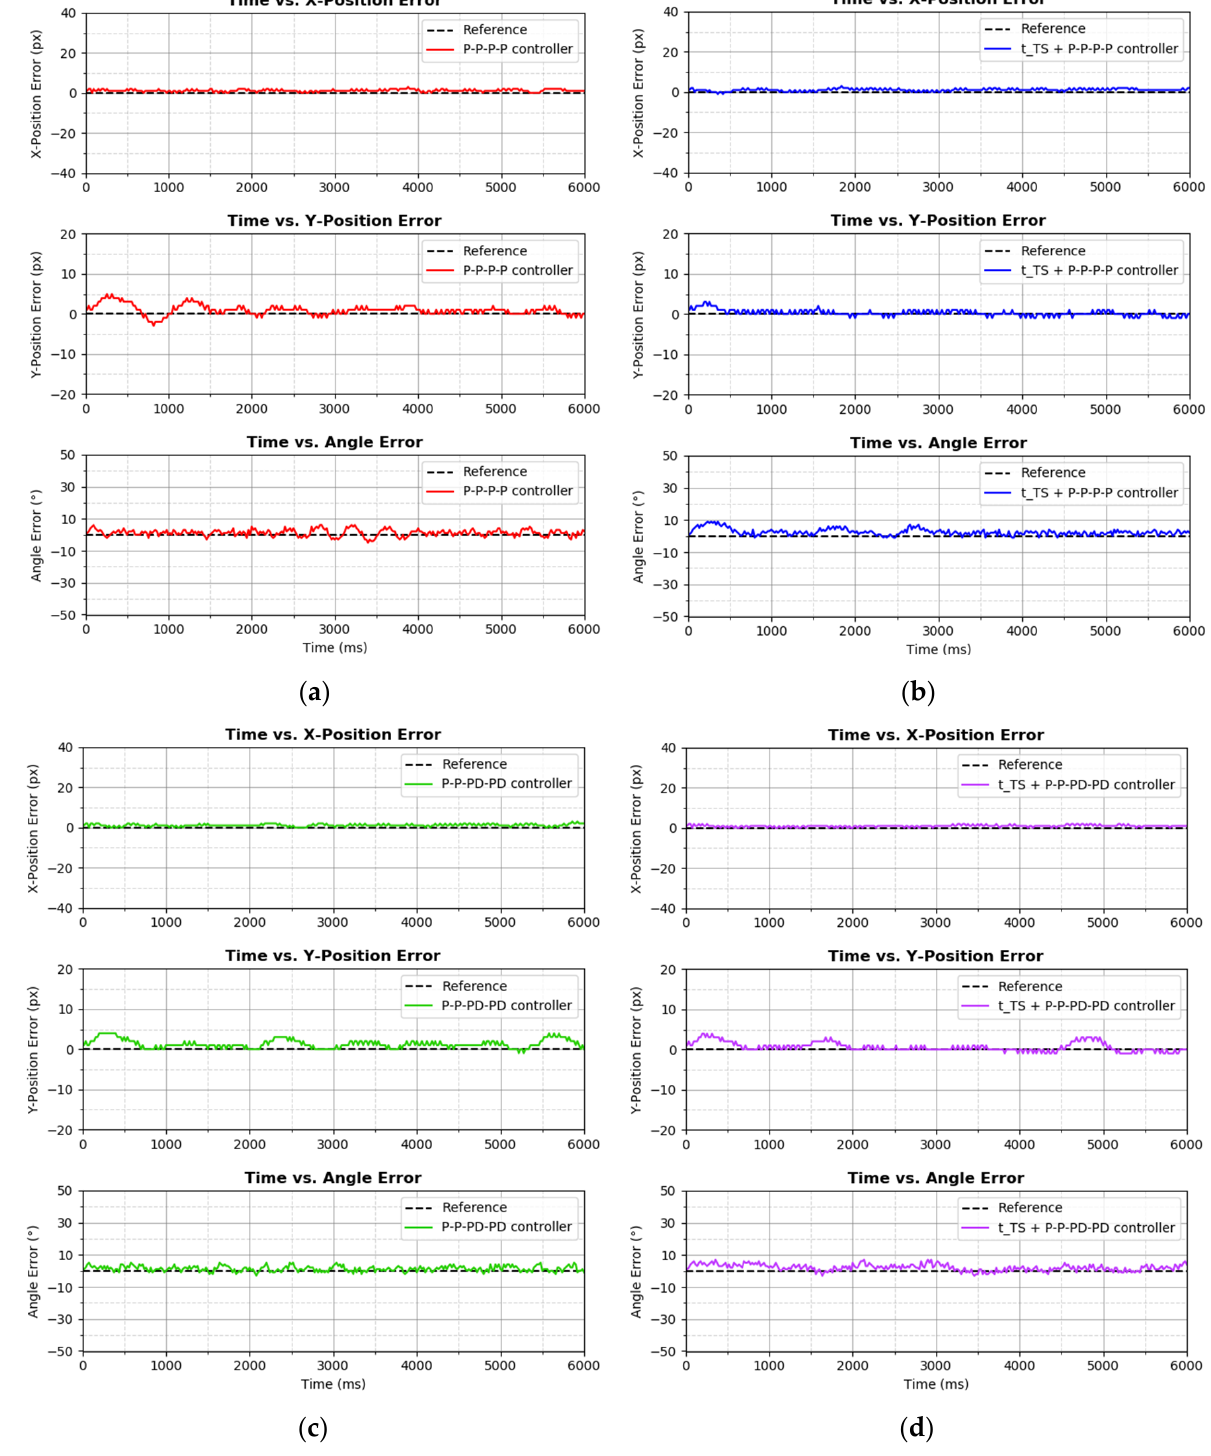
Figure 18. Diagonal-shaped trajectory tracking performance by ( a ) P–P–P–P controller, ( b ) t TS + P–P–P–P controller, ( c ) P–P–PD–PD controller, and ( d ) t TS + P–P–PD–PD controller on